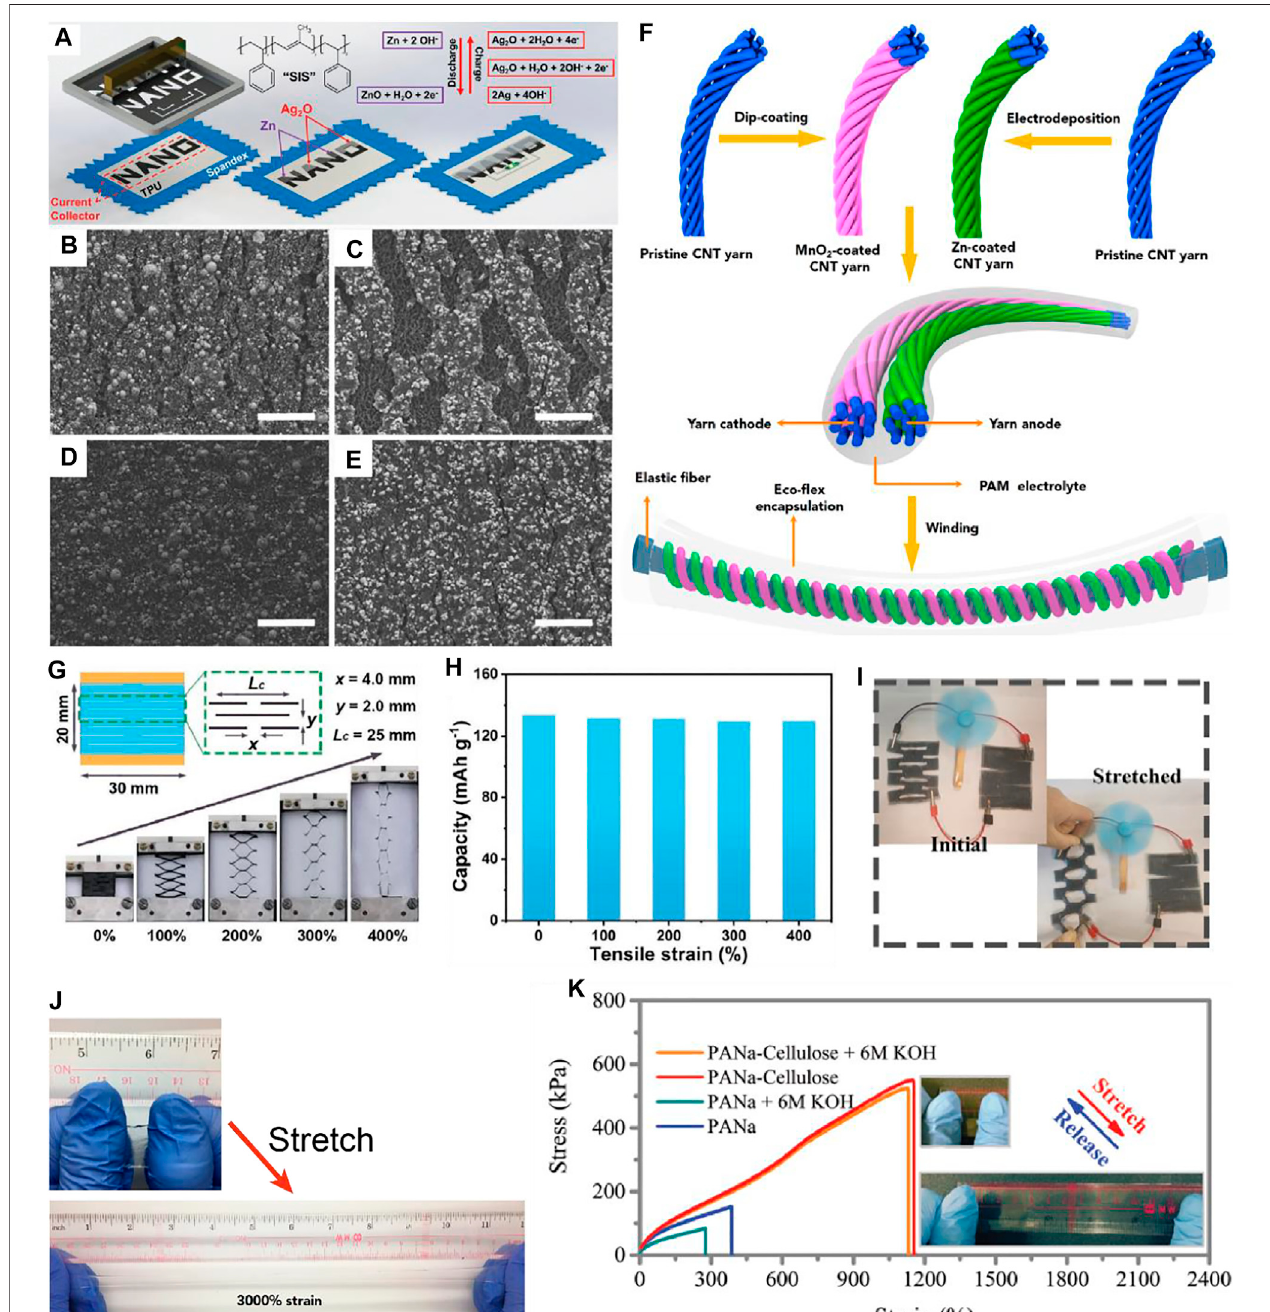
FIGURE 2 | (A) Screen-printing steps of a Zn – Ag 2 O battery on a stretchable textile, exhibiting the cathode and anode reactions. Stretched states of the Zn anode (B) andtheAg 2 Ocathode (C) ,andrecoveredstatesoftheZnanode (D) andtheAg 2 Ocathode (E) ,respectively;scalebar:50 µm(reproducedfromKumaretal.(2019)). (F) Schematicdiagramofthefabricationprocessofthe fi ber-shapedbatteries(reproducedfromLietal.(2020)). (G) KirigamistrategiestoobtainZn – polyanilinebatteries with 400% stretchability. (H) The stable capacity retention under different tensile strain values (reproduced from Yao et al. (2021)). (I) Kirigami strategies to realize Zn – air batteries with 100% stretchability to power a fan (reproduced from Qu et al. (2020)). (J) The PAM hydrogel electrolyte for mild Zn battery systems with a stretchability over 3,000% (reproduced from Li et al. (2020)). (K) The PANa hydrogel electrolyte for alkaline Zn battery systems with a stretchability over 1,100% (reproduced from Ma et al. (2019)).